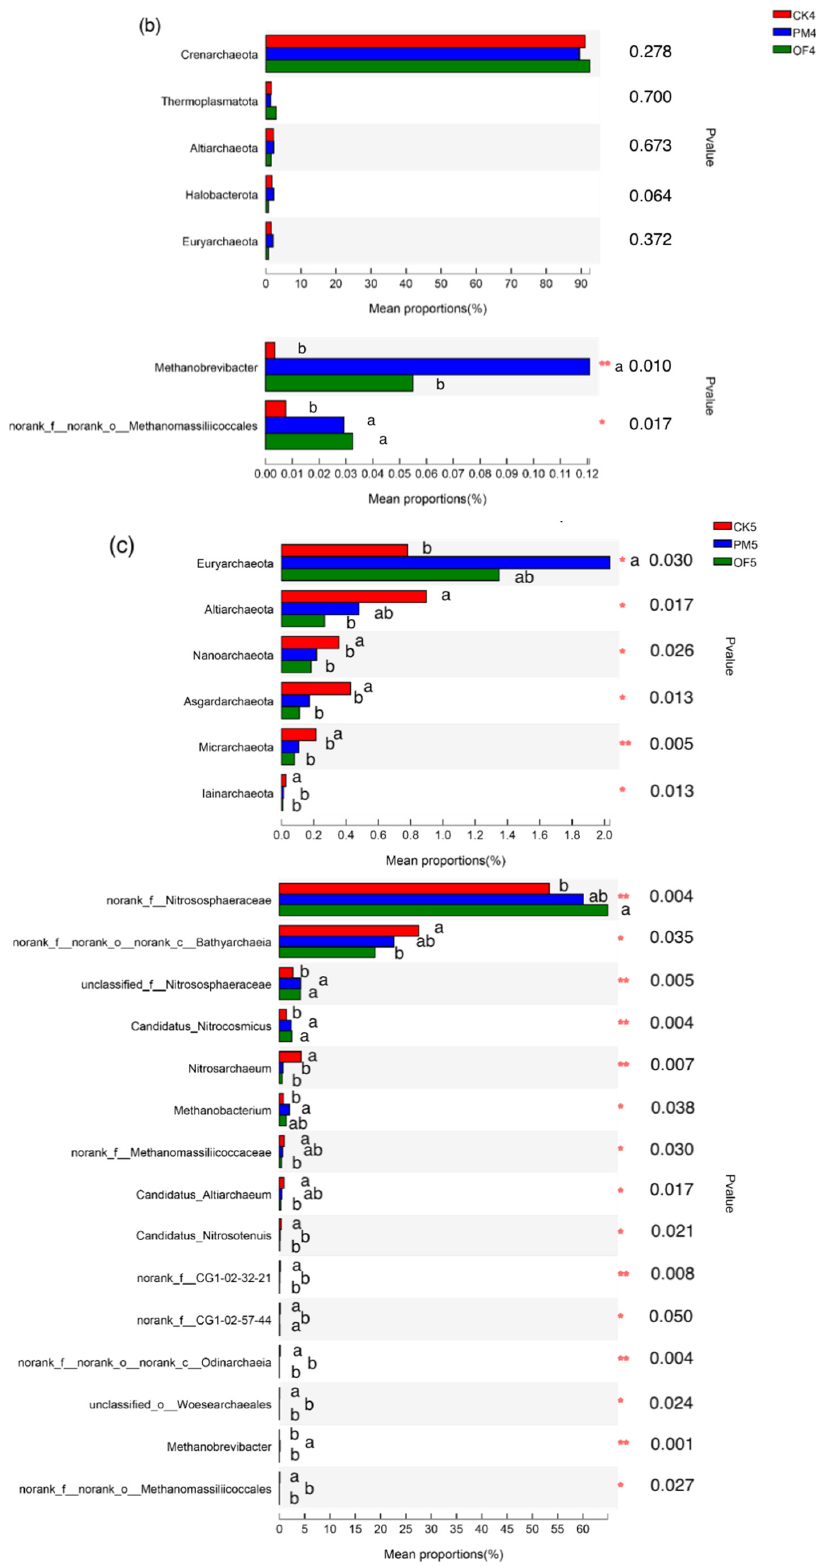
Figure 4. Univariate ANOVA of intergroup differences in microphylum and genus levels in paddy fields: ( a ) Heading stage; ( b ) Flowering stage; ( c ) Mature stage. * indicates (p < 0.05), ** indicates ( p < 0.01).